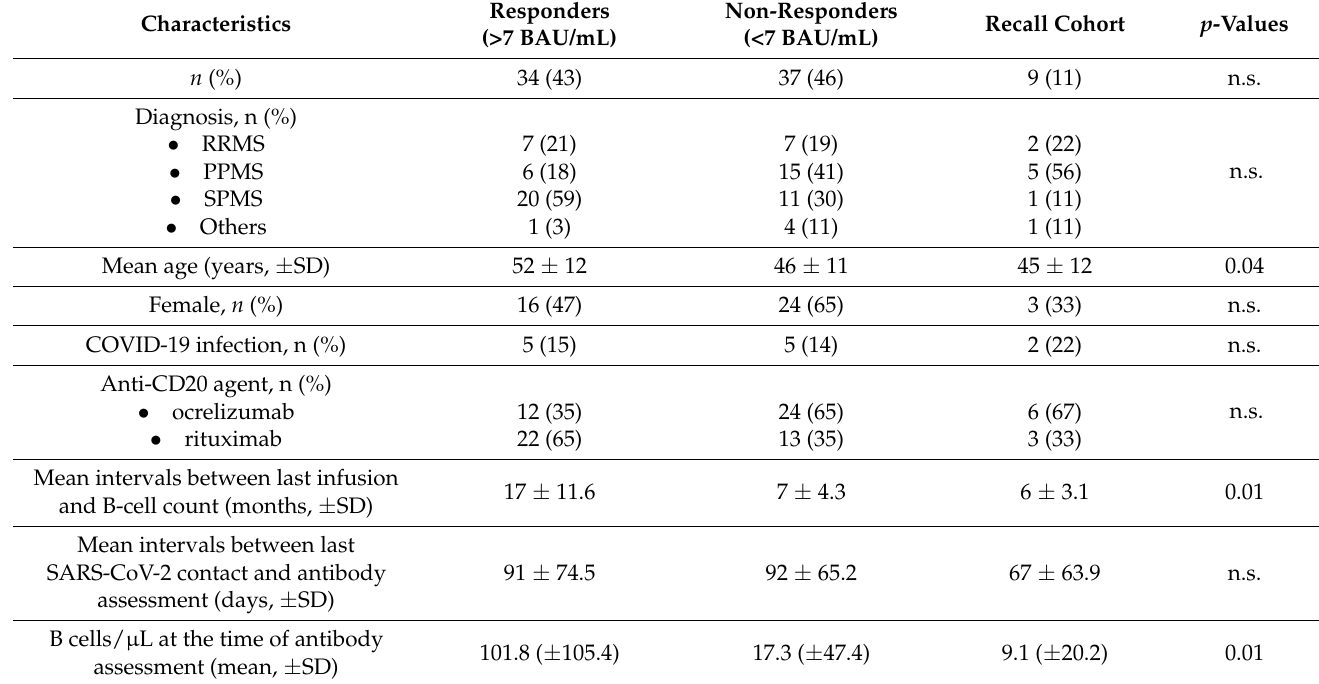
Table 1. Demographic features and patient characteristics among the three cohorts.